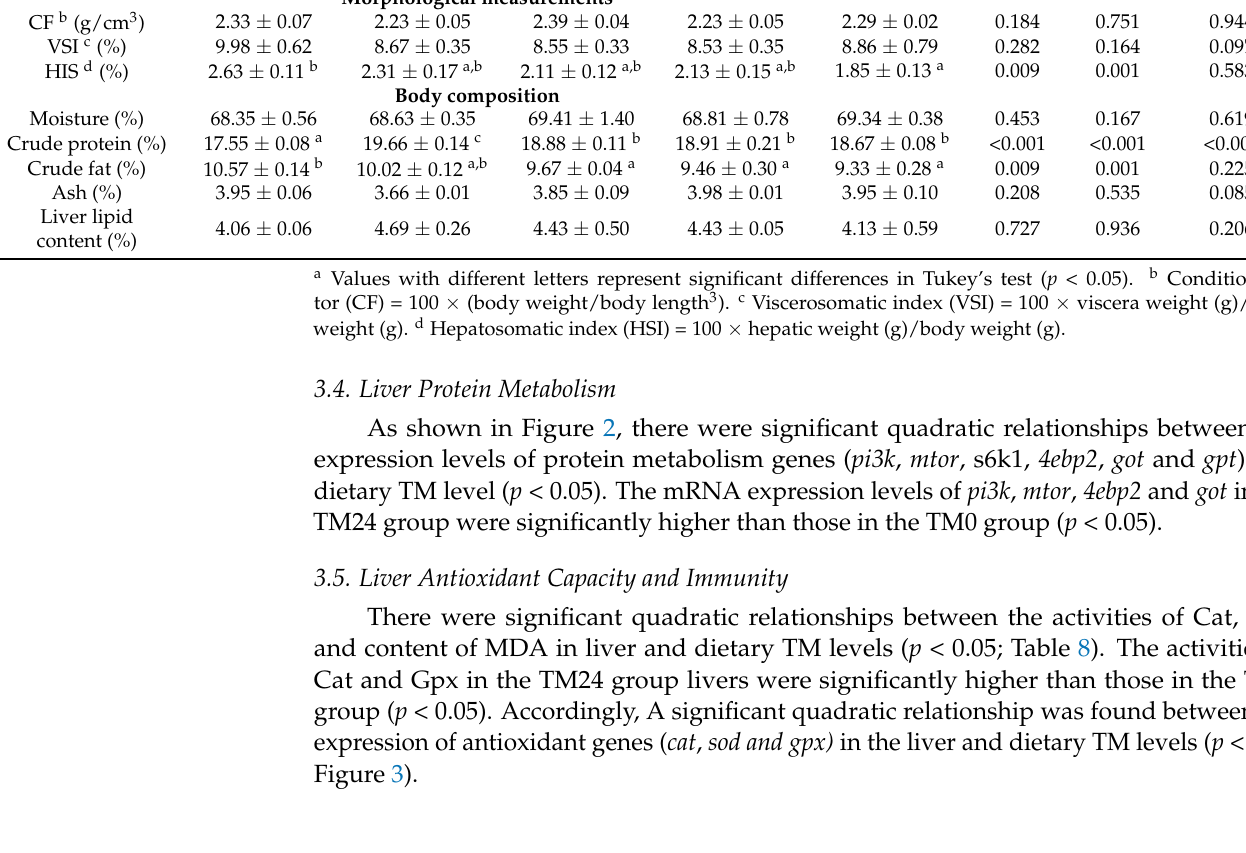
Table 7. Effects of fishmeal replacement with TM on body morphological measurements and body composition of Micropterus salmoides a .